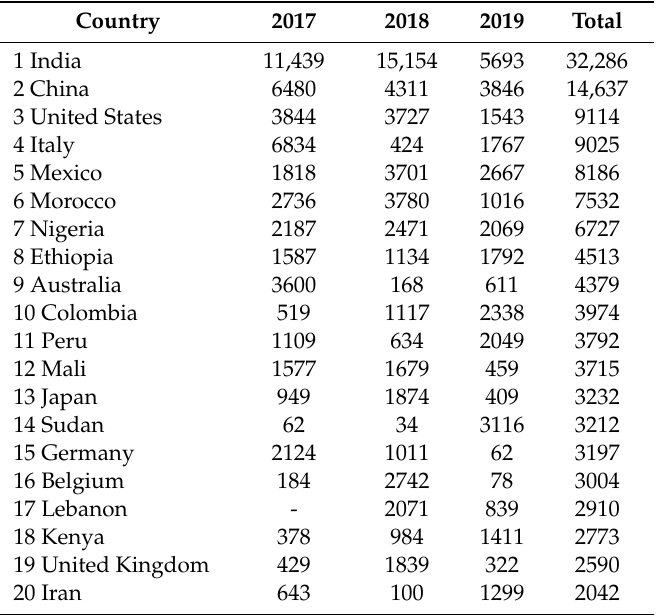
Table 2. 20 countries which received the most samples from the CGIAR genebanks, 2017–2019 (not including intra- and inter-CGIAR Center